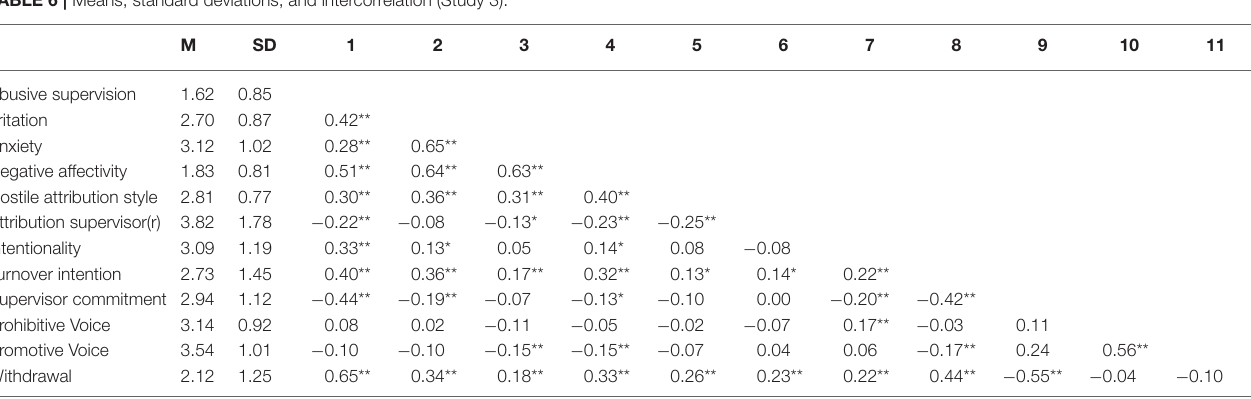
TABLE 6 | Means, standard deviations, and intercorrelation (Study